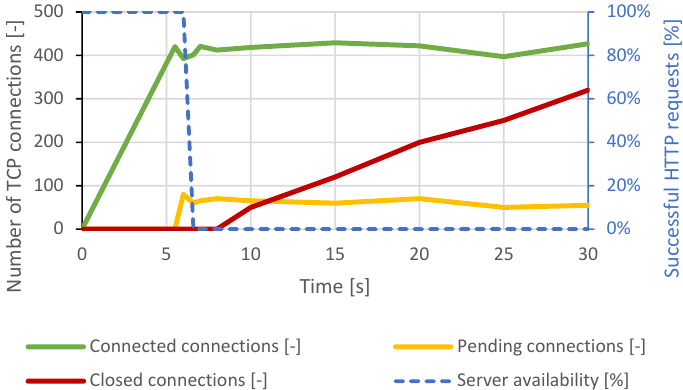
Figure 17. SlowDrop attack against lighttpd